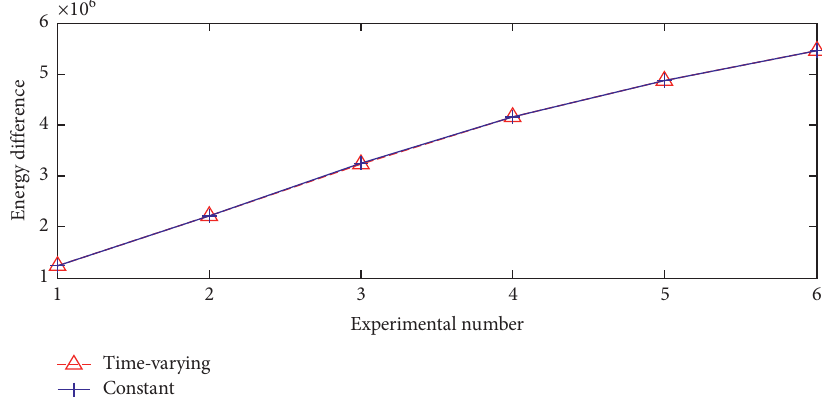
Figure 22: Signal energy of s- p